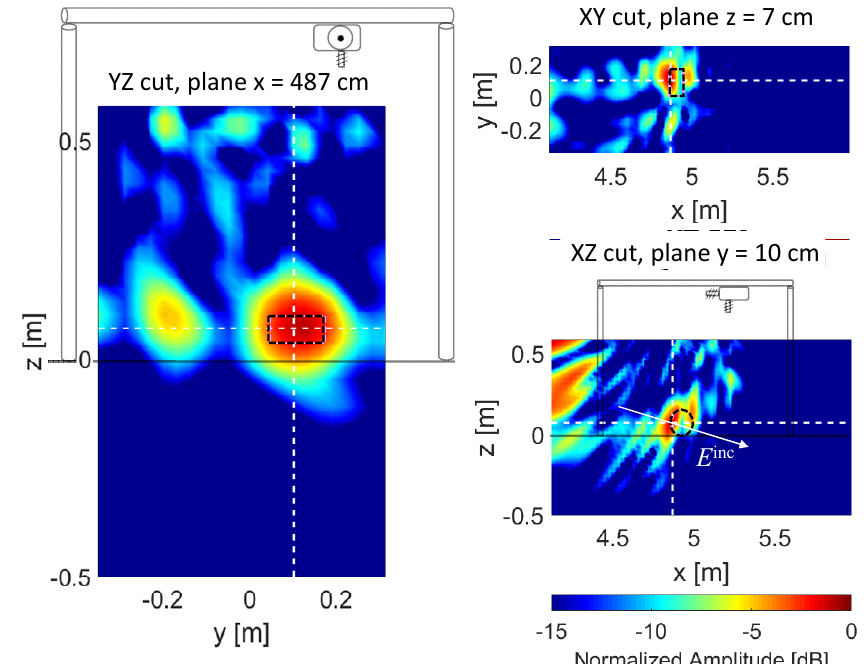
Figure 9. Imaging results for the metallic can placed on the ground. GPR-SAR cuts are centered at the position of the target, the profile of which is highlighted with a black dashed line. The white arrow depicted in the XZ cut represents the direction of the incident field ( − 12° with respect to the horizontal plane). For reference purposes, the air–ground interface ( z = 0 m) and a sketch of the layout of the portable setup are depicted in black color in the YZ and XZ cuts.